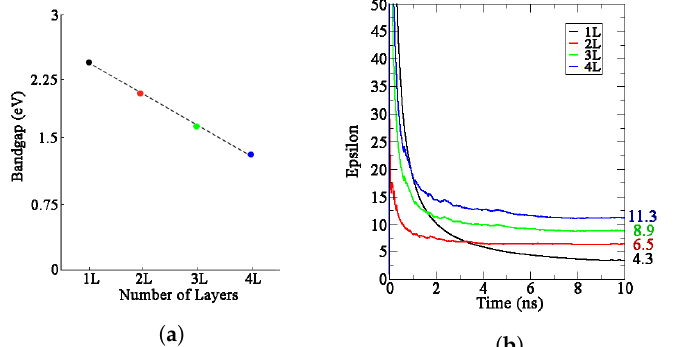
Figure 6. Bandgap values of MoS 2 structures in function of the number of layers ( a ). Dielectric constant values of MoS 2 systems in function of simulation time ( b